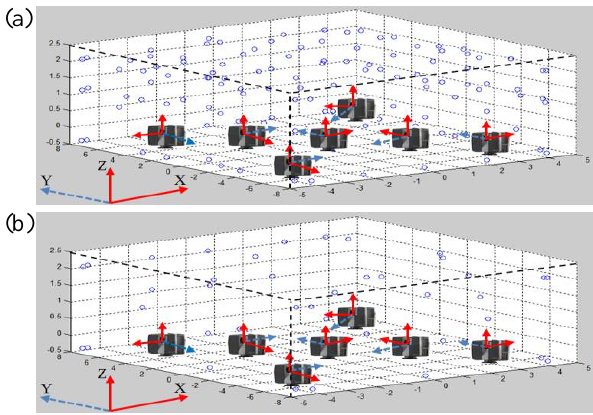
Figure 5. Reducing the number of targets, (a) Ten percent targets reduced and (b) Seventy percent targets